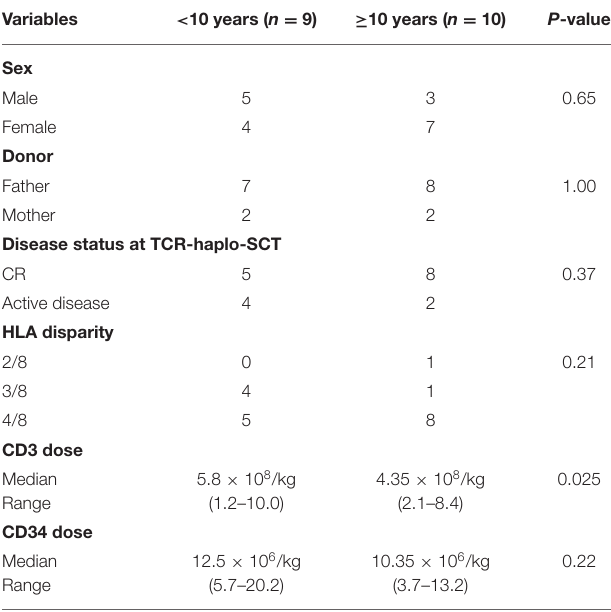
TABLE 4 | Comparison of patient characteristics by